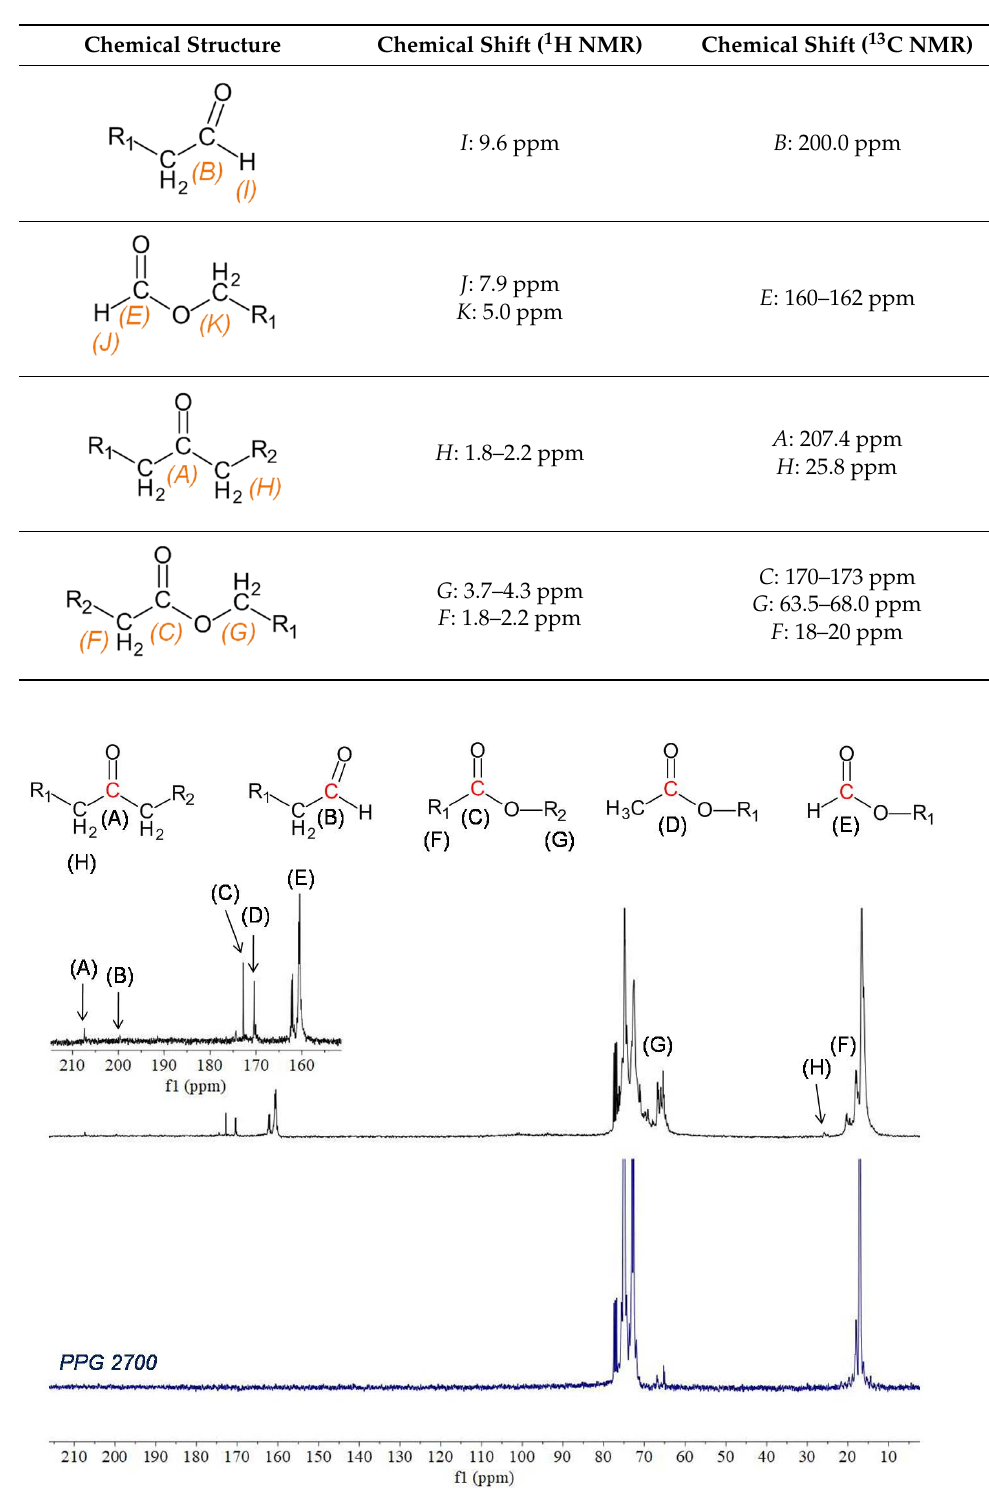
Table 3. Chemical structures and assignment of characteristic groups to signals in 1 H and 13 C NMR spectra. Table 3. Cont .